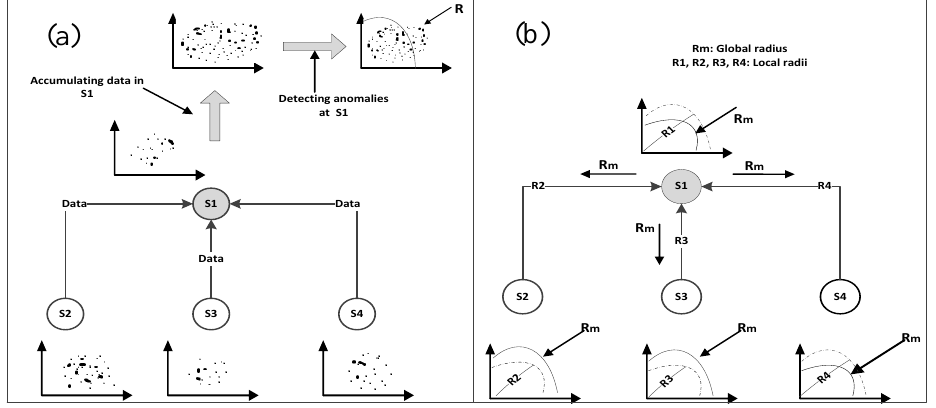
Figure 7. ( a ) Centralized vs. ( b ) distributed anomaly detection using QSSVM approach